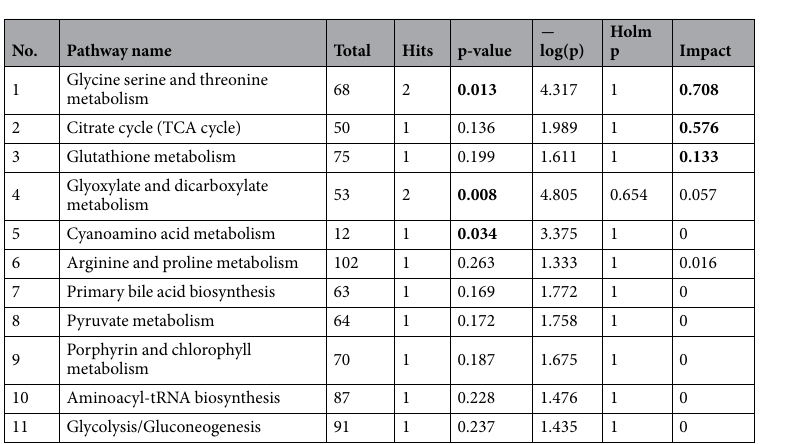
Table 5. The results of the joint pathway analysis from discriminating metabolites between EG and RG groups. Legend: Total represents the total number of compounds involved in a pathway, Hits is the actual number of matched metabolites in one pathway, Holm p is Holm-Bonferroni adjusted p value and Impact is the pathway impact value from a pathway topology